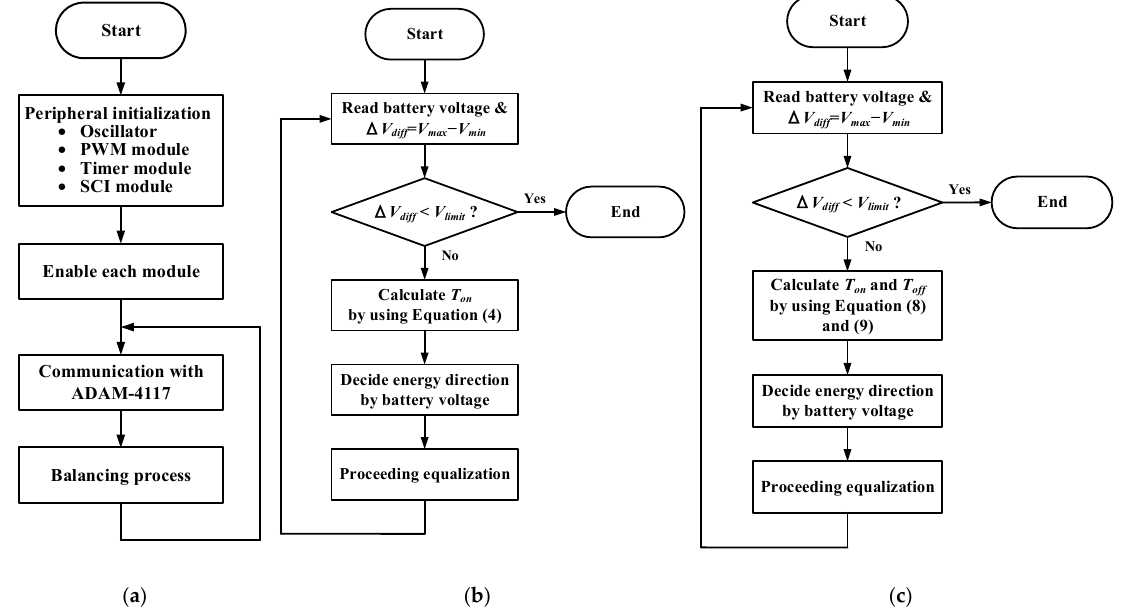
Figure 6. Software flowchart of the proposed balancing strategy: ( a ) main program; ( b ) balancing program of the VOT method; and ( c ) balancing program of the VRM method.